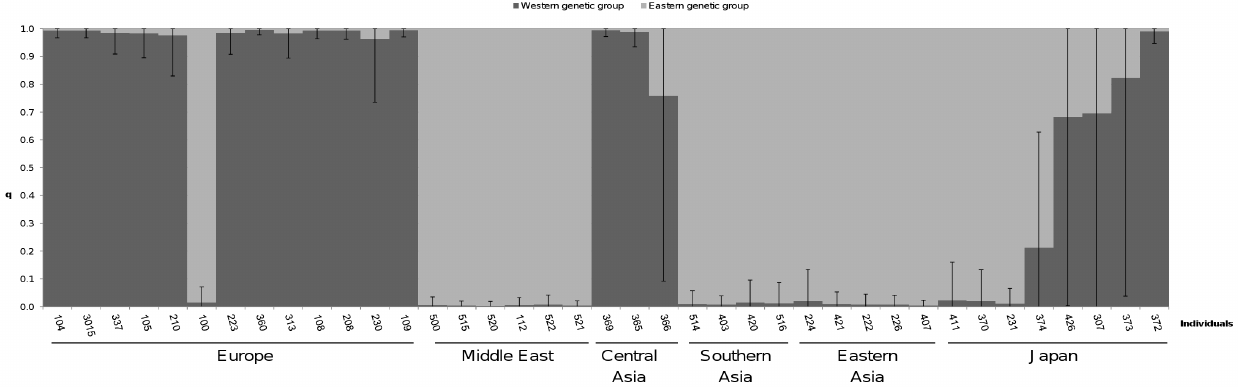
Figure 2. Genetic structure of 39 carrot cultivars based on a Bayesian approach on microsatellite data and assuming two clusters. Each individual is represented by a single vertical box broken in two coloured segments, with length proportional to each cluster assignment probability ( y -axis). Bars represent the 95% confidence interval. The individuals are placed on the x -axis according to the approximate longitude of their country of origin, from France (left) to Japan (right).